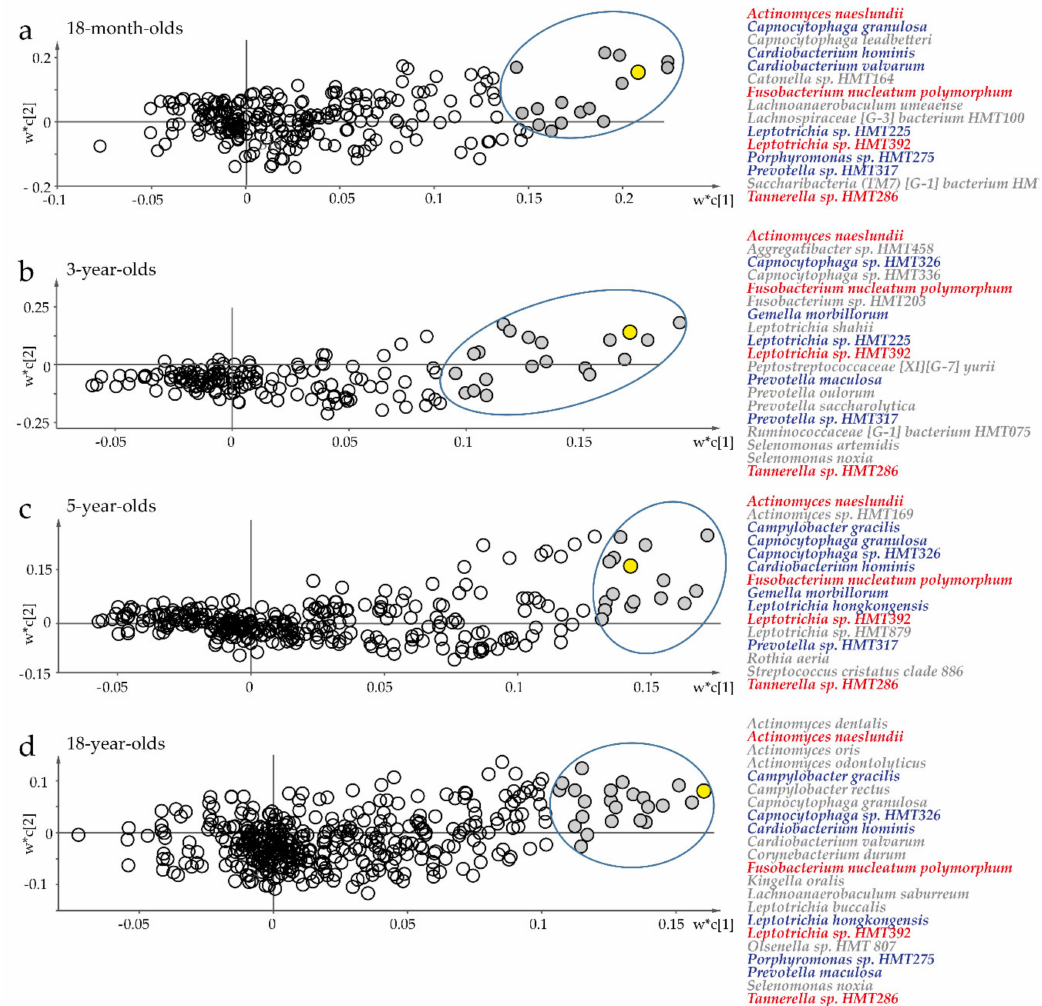
Figure 3. Multivariate partial least squares (PLS) regression of saliva microbiota to target potential partner bacteria for C. matruchotii . Scatter plots of PLS loading based on a model with C. matruchotii abundance as the dependent variable (Y, yellow filled symbol) and abundance of all other detected species in saliva swab samples as the independent variable block (X) for ( a ) 18-month-old infants, ( b ) 3-year-old children, ( c ) 5-year-old children, and ( d ) young adults. Unfilled symbols represent species with variable importance in projection (VIP) < 2.0. Red text indicates species that were found in saliva at all ages, and blue indicates those found at two or three ages. w * describes the PLS weights from the combination of the original variables in the X-swarm; c is the component number. Species with a significant VIP score > 2.0 are